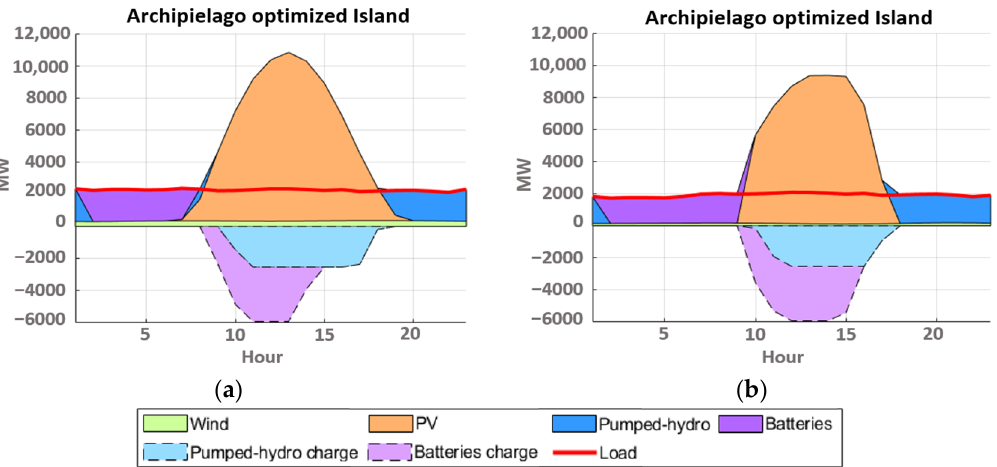
Figure 21. Hourly performance of generation and storage systems in a typical day of ( a ) summer and ( b ) winter. ( b )